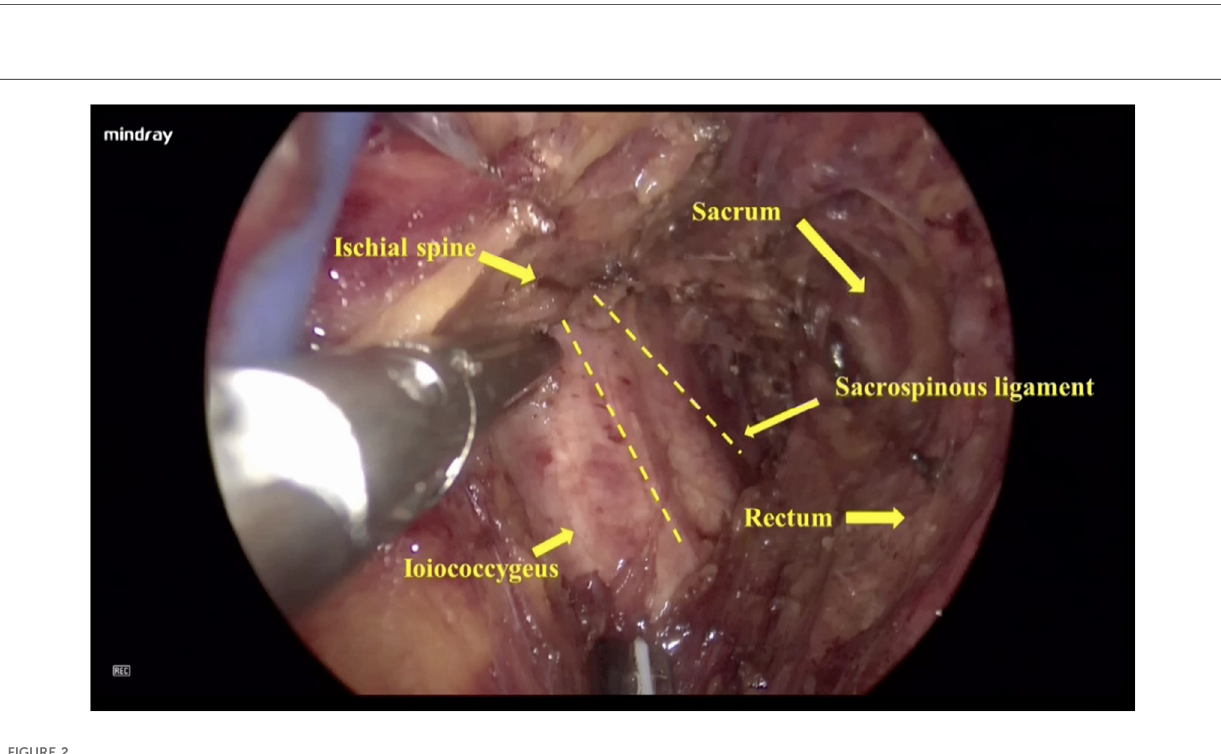
FIGURE 2 Sacrospinous ligament exposure. An ultrasonic scalpel was used to laparoscopically separate the loose tissues next to the rectum until the sacrospinous ligament, the adjacent piriformis, and iliococcygeal muscles were fully